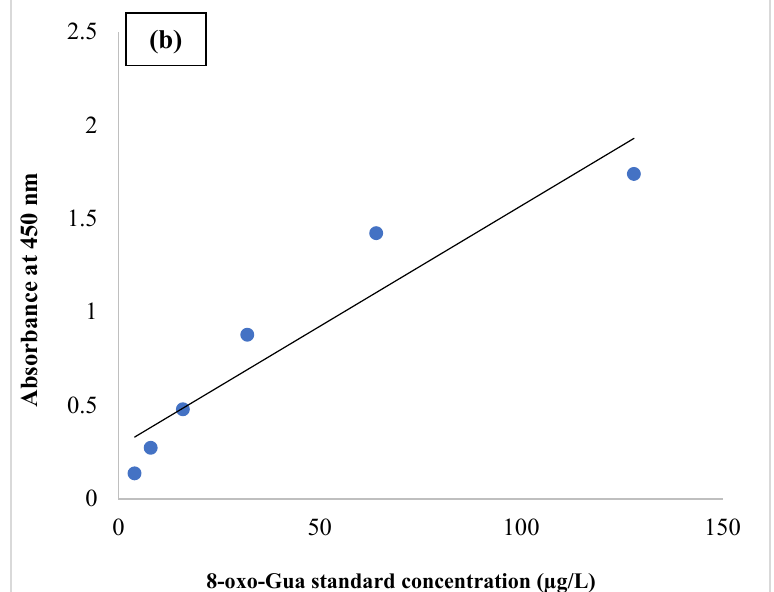
Figure 1. Standard curves of Pb ( a ), 8-oxo-Gua ( b ), and MDA ( c ). 2.4. Statistical Analysis The Kolmogorov–Smirnov analysis was applied with SPSS-v.20 (SPSS Inc., Chicago, IlL, USA) statistical software to determine that the collected data of the individuals had a normal distribution, and an independent t-test was utilized to compare the results of the opium addict and non-addict persons. 3. Results and Discussion Table 1 shows that the majority of addicts (60%) and non-addicts (52%) were males. Additionally, most addicts (76%) and non-addicts (72%) are between 20 and 40 years old. Moreover, over half of both addicted and non-addicted individuals had an academic qual- ification (e.g., Associate’s degree, BSc., MSc., and Ph.D.), and most addicts and non-ad- dicts were employed, according to the study’s findings. A total of 16% of non-addicts had